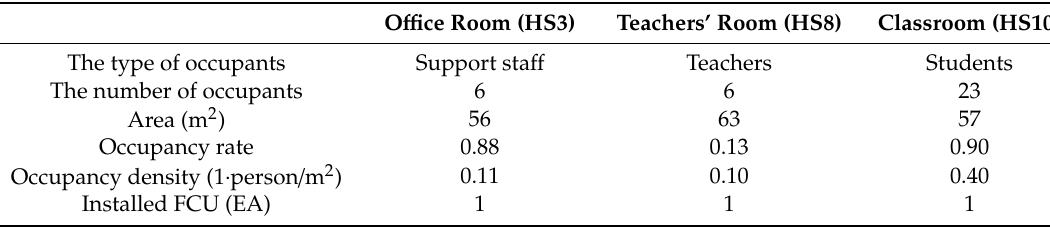
Table 3. Room information.